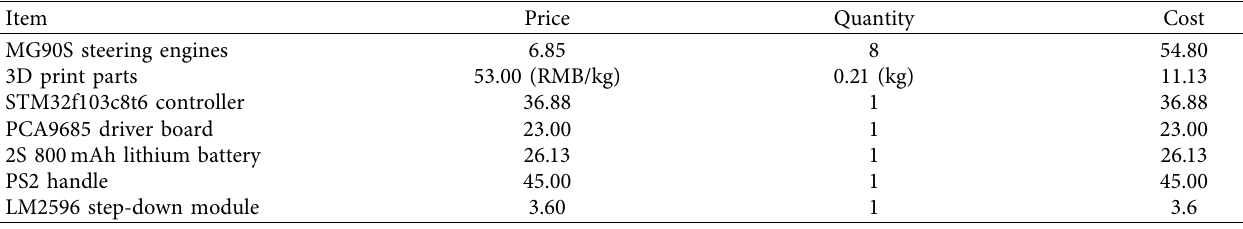
Table 2: The prototype BOM.